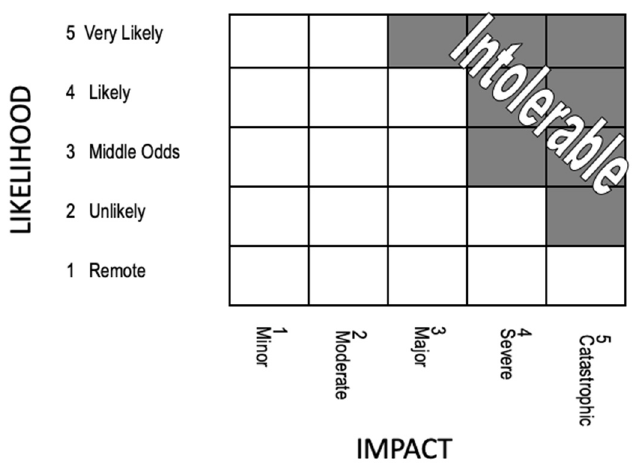
Figure 1. A typical risk map format.